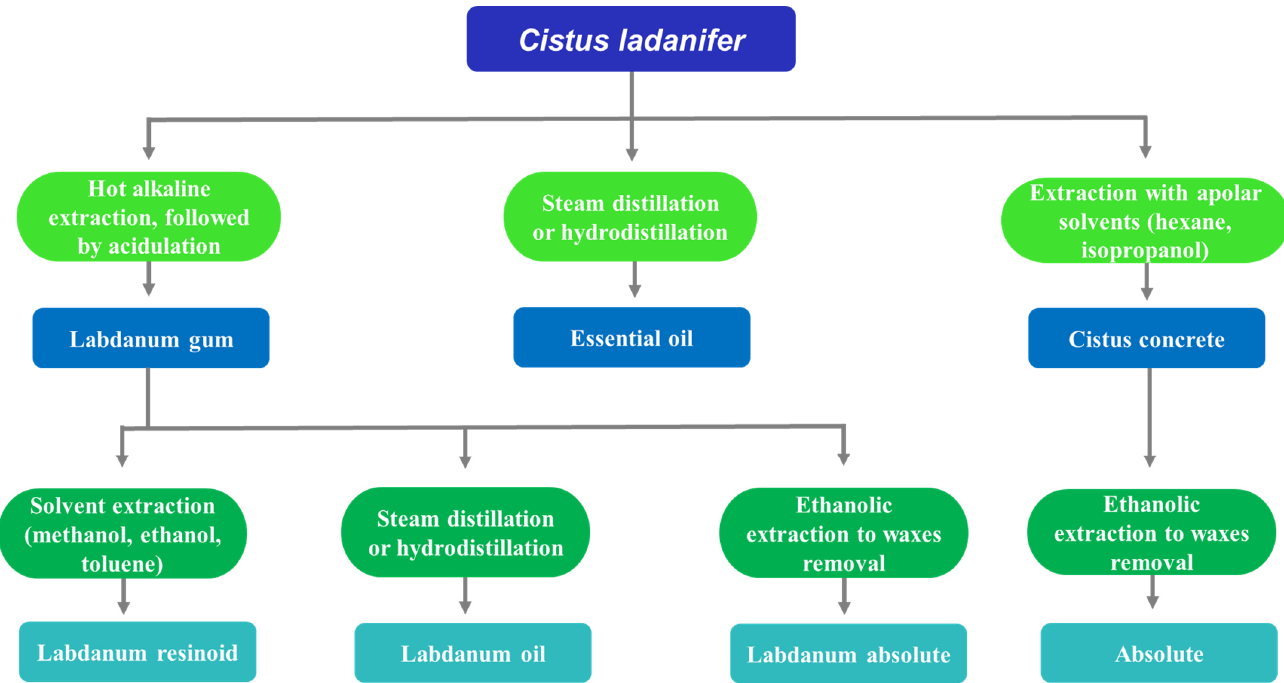
Figure 2. Main conventional aromatic extracts obtained from C. ladanifer and respective extraction